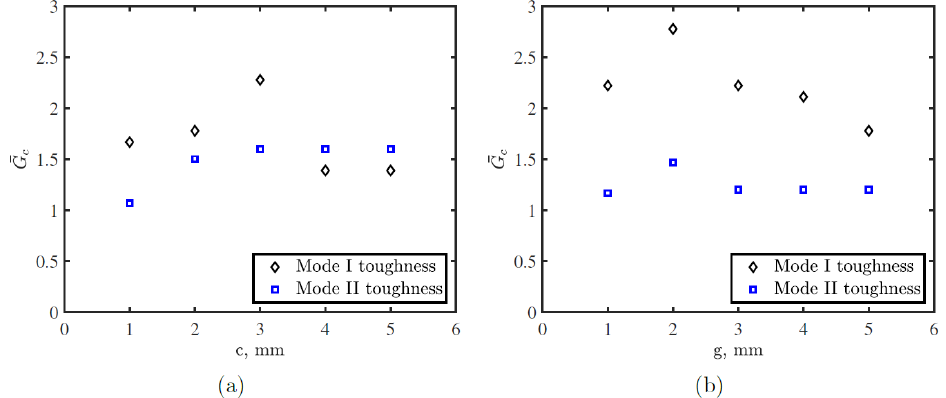
Figure 12. Toughened thermoplastic adhesive tapes microstructure effects on mode I and II toughness with respect to the defect length c at a gap between successive defects g = 5 mm in ( a ) and g at c = 2 mm in ( b ). The analysis in the figure was extracted from the FE